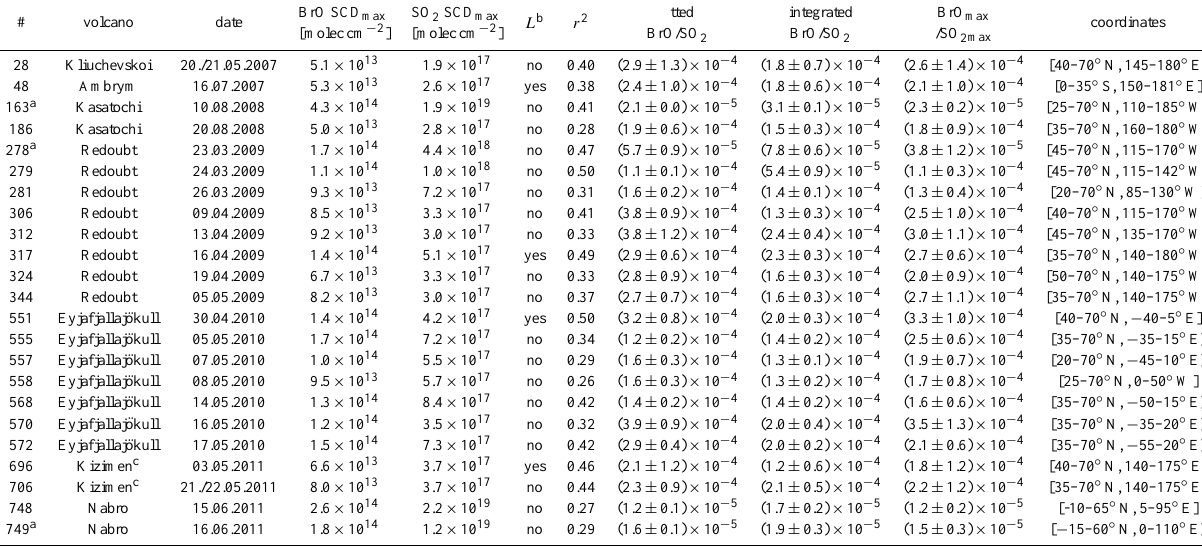
Table 5. Category II ( weak linear correlation ) BrO/SO 2 -analysis of all detected volcanic plumes of Category II. Columns contain: event number, volcano, measurement date, max. BrO SCD, max. SO 2 SCD, coincidence of max. SO 2 and BrO SCD, r 2 , BrO/SO 2 slope, ratio of integrated BrO and SO 2 molecules, ratio of max. SO 2 and coordinates of regarded